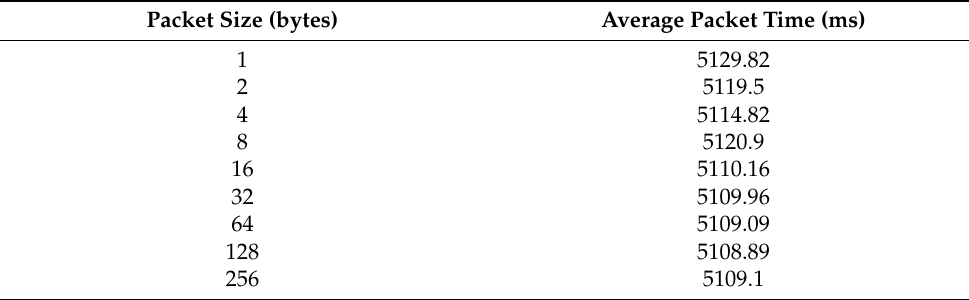
Table 3. WIC UWB node (PDHU) to WIC UWB GW (CDHU) average end-to-end